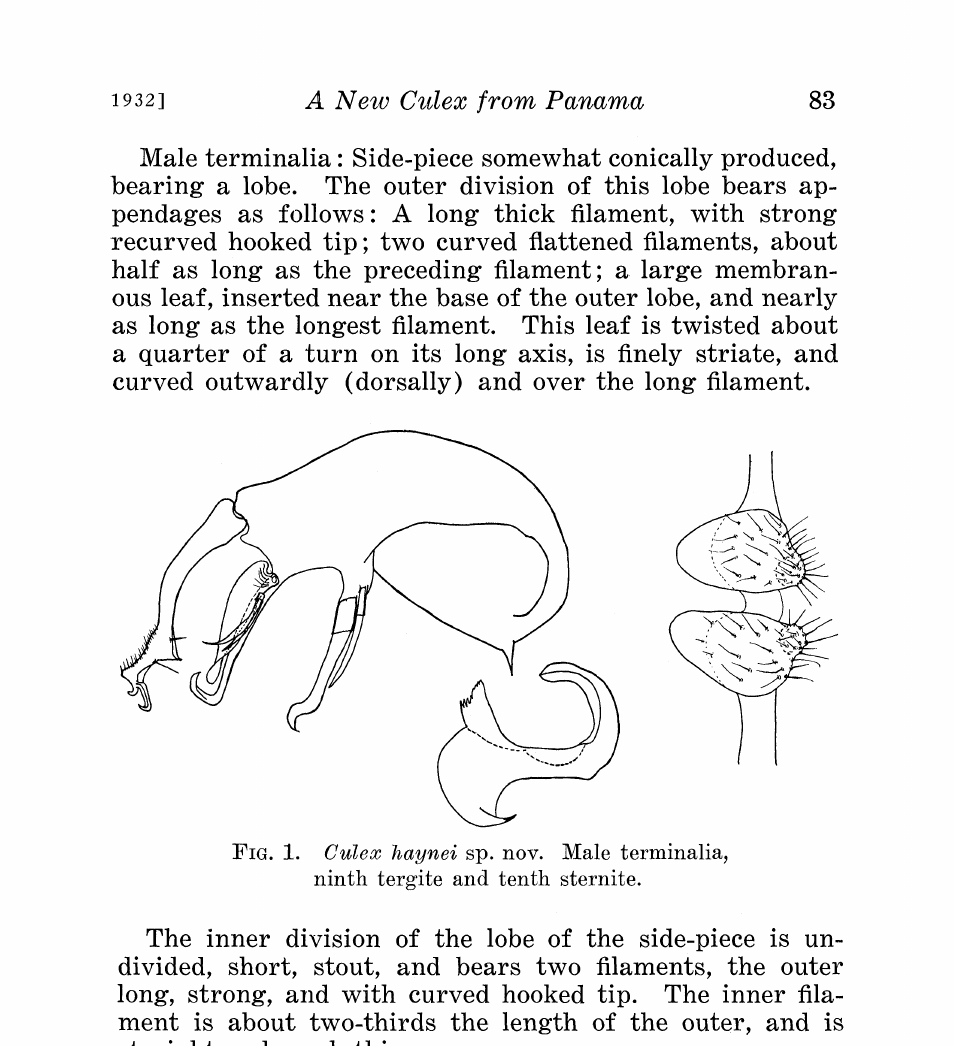
FIG. 1. Culex haynei sp. nov. Male terminalia, ninth tergite and tenth